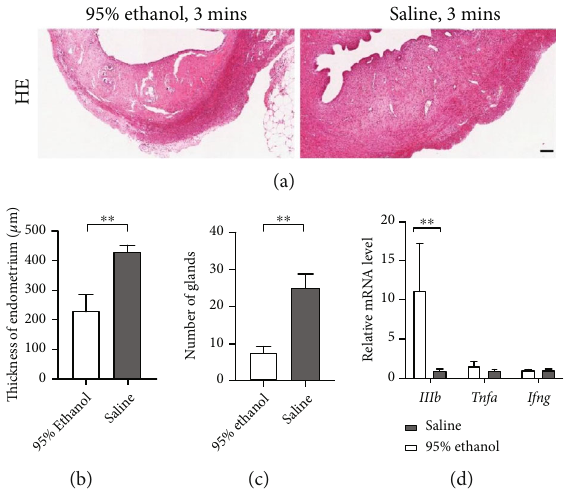
Figure 3: Generation of thin endometrial injury rat model. (a) HE staining of 95% ethanol and saline injection uterine horn. Scale bar = 100 μ m. (b) Measurement of endometrium thickness between 95% ethanol and saline injection group. Results were presented as mean ± S : E : M , n = 9 . Welch ’ s t -test was used for signi fi cant di ff erence test ( ∗∗ P < 0 : 01 ). (c) Quantitative analysis of number of glands in each slide between 95% ethanol and saline injection group. Results were presented as mean ± S : E : M , n = 9 . Student ’ s t -test was used for signi fi cant di ff erence test ( ∗∗ P < 0 : 01 ). (d) Q-PCR analyzed the relative gene expression of in fl ammatory factors ( Il1b , Tnfa , and Ifng ). Data was reported as mean ± S : E : M . Student ’ s t -test was applied for signi fi cant di ff erence ( ∗∗ P < 0 : 01 and ns=nonsigni fi cant), n = 9